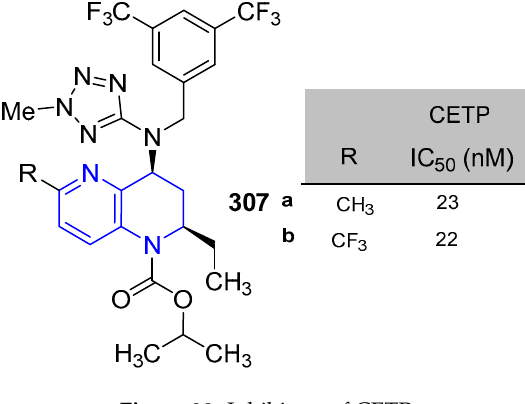
Figure 28. Inhibitors of CETP.